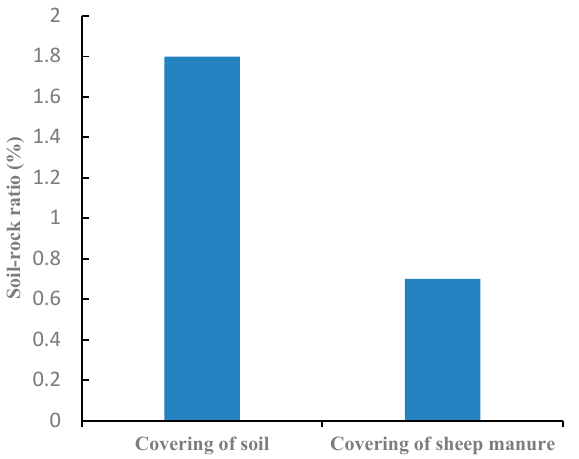
Figure 5. Soil-rock ratio under the soil measures.